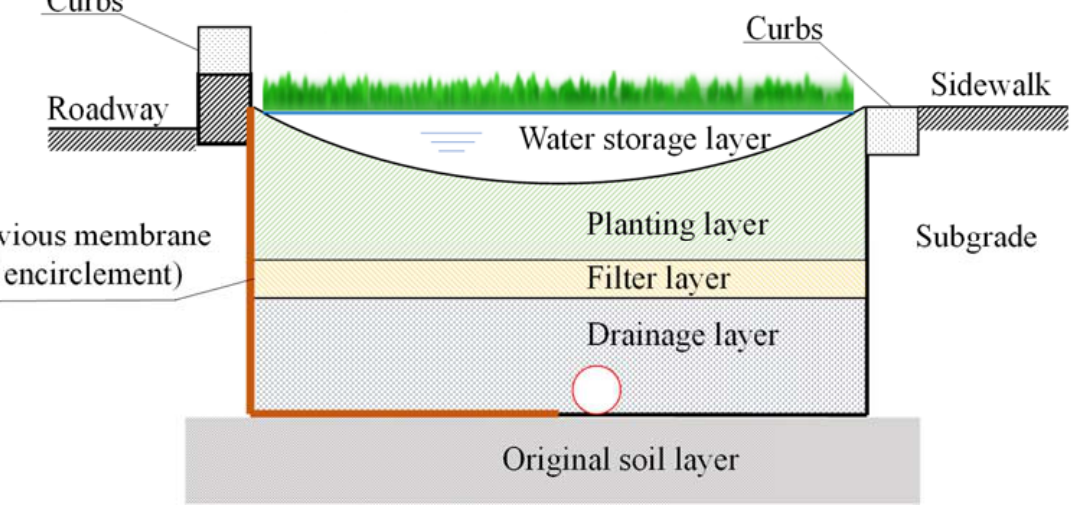
Figure 1. Cross ‐ sectional view of road bioretention. Figure 1. Cross-sectional view of road